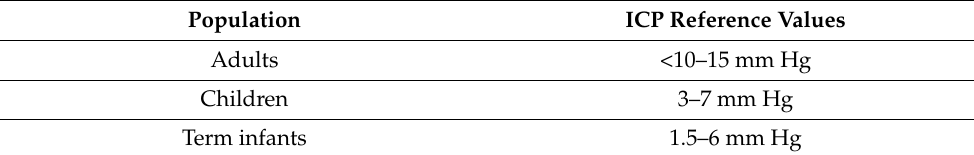
Table 1. Suggested age-related intracranial pressure (ICP) reference